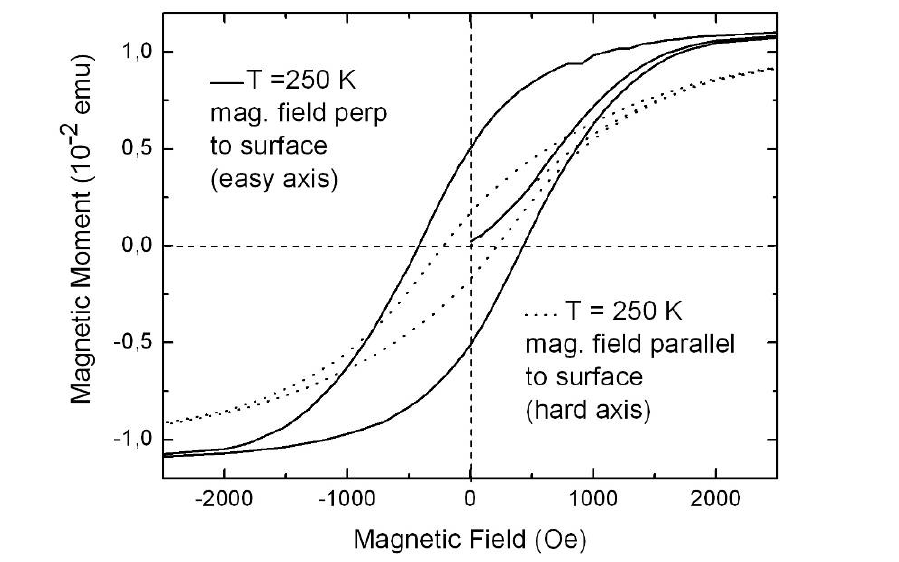
Figure 28. Magnetization measurements of elongated NiCo-structures (~500 nm) within PS exhibit a magnetic anisotropy of about 50% between easy axis and hard axis direction (diameter ~60 nm)